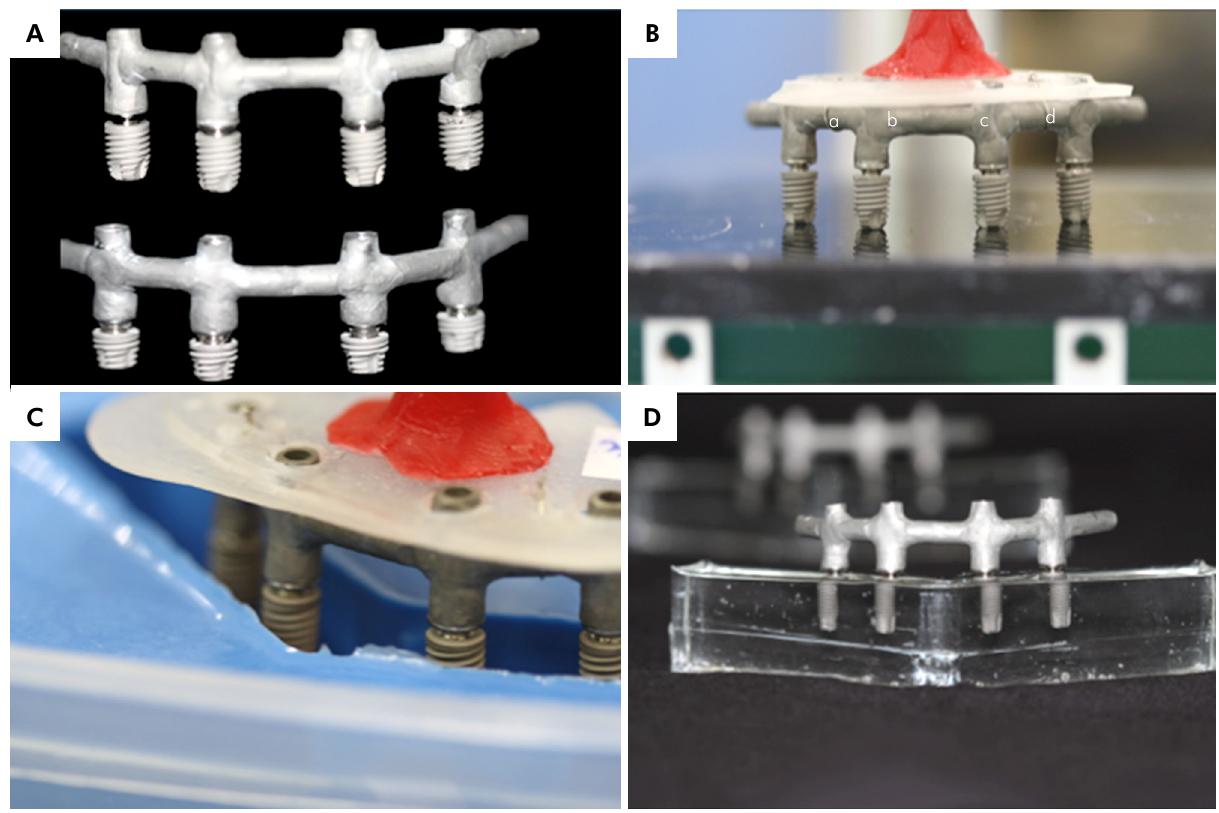
Figure 3. Photoelastic model: A) Implants, abutments and bar. B) Parallelism between the implants. C) The set inserted in the mold. D) Definitive